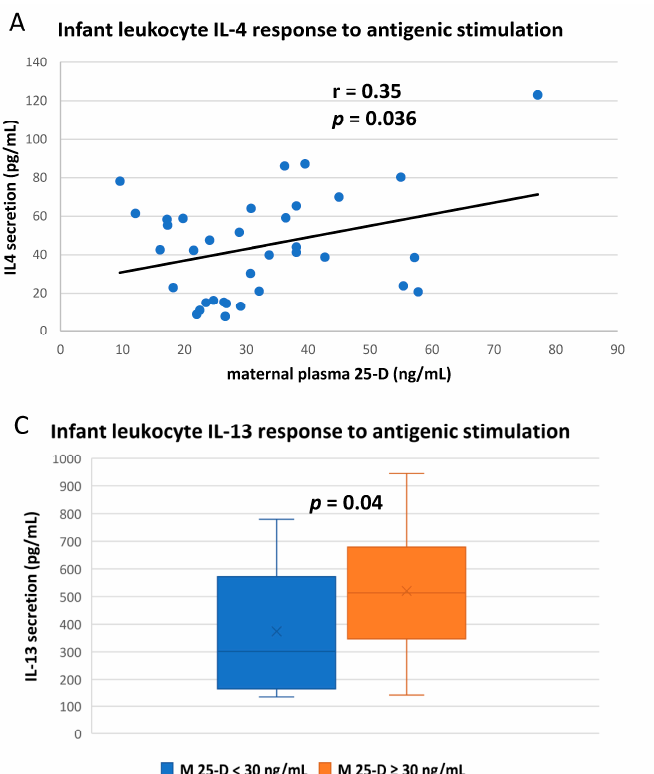
Figure 3. TNF and IFN γ responses of infant leukocytes to in vitro antigenic stimulation. Whole blood from breastfeeding infants was stimulated with antigen stock mixture for 20 h; culture super- natants were then collected for cytokine measurement by electrochemiluminescence. Mean cytokine concentrations compared between infants based on maternal vitD sufficiency (maternal plasma 25- D ≥ 30 ng/mL; unpaired t -tests) at the corresponding time of blood draw. ( A ) Mean infant TNF. ( B ) Mean infant IFN γ .